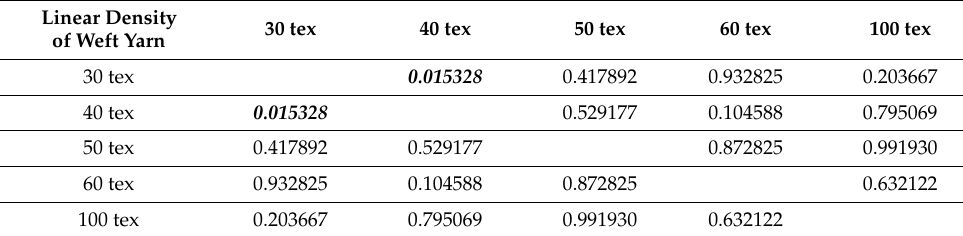
Table 14. The results of the Tukey’s test for the OMMC. Linear Density of Weft